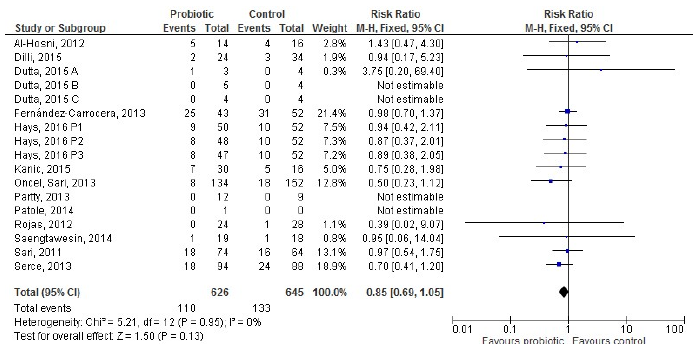
Figure 5. The forest plot shows the association between the use of probiotics and late onset sepsis in the thirteen studies reporting data for preterm infants receiving mixed feeding. M–H: Mantel–Haenszel